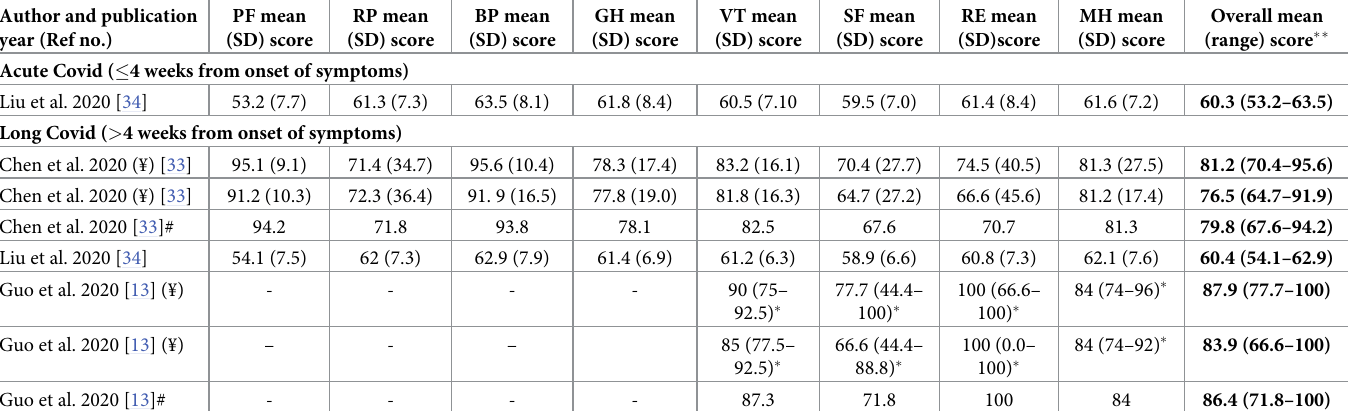
Table 3. SF-36 components’ score reported in different studies (Acute Covid and Long